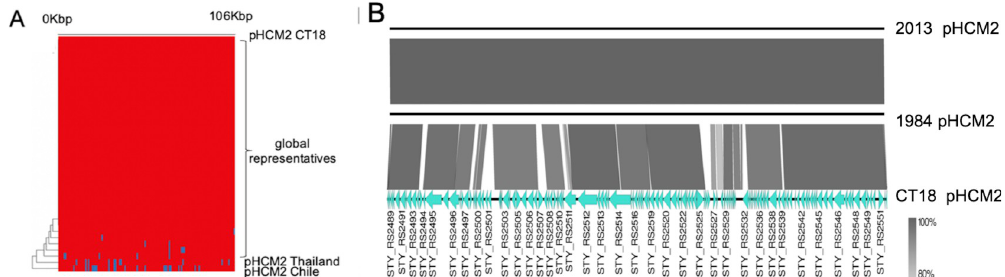
Fig 4. Genetic comparison of cryptic plasmid pHCM2-like sequences. Global representative collection of pHCM2 aligned to the reference pHCM2 from CT18. (A) Presence and absence of genes located on pHCM2. Red indicates presence of the genes located on the reference pHCM2 sequence from CT18, while blue indicates absence of the genes compared to the reference. Nucleotide BLAST comparison of the 2 Chilean assembled pHCM2-like plasmids (ERR271054, ERR4289185) against the reference pHCM2 plasmid from S . Typhi CT18 (accession no:AL513384) (B). Gene annotations are shown for the reference pHCM2 from CT18, with the shading intensity indicating percent nucleotide homology between the plasmid